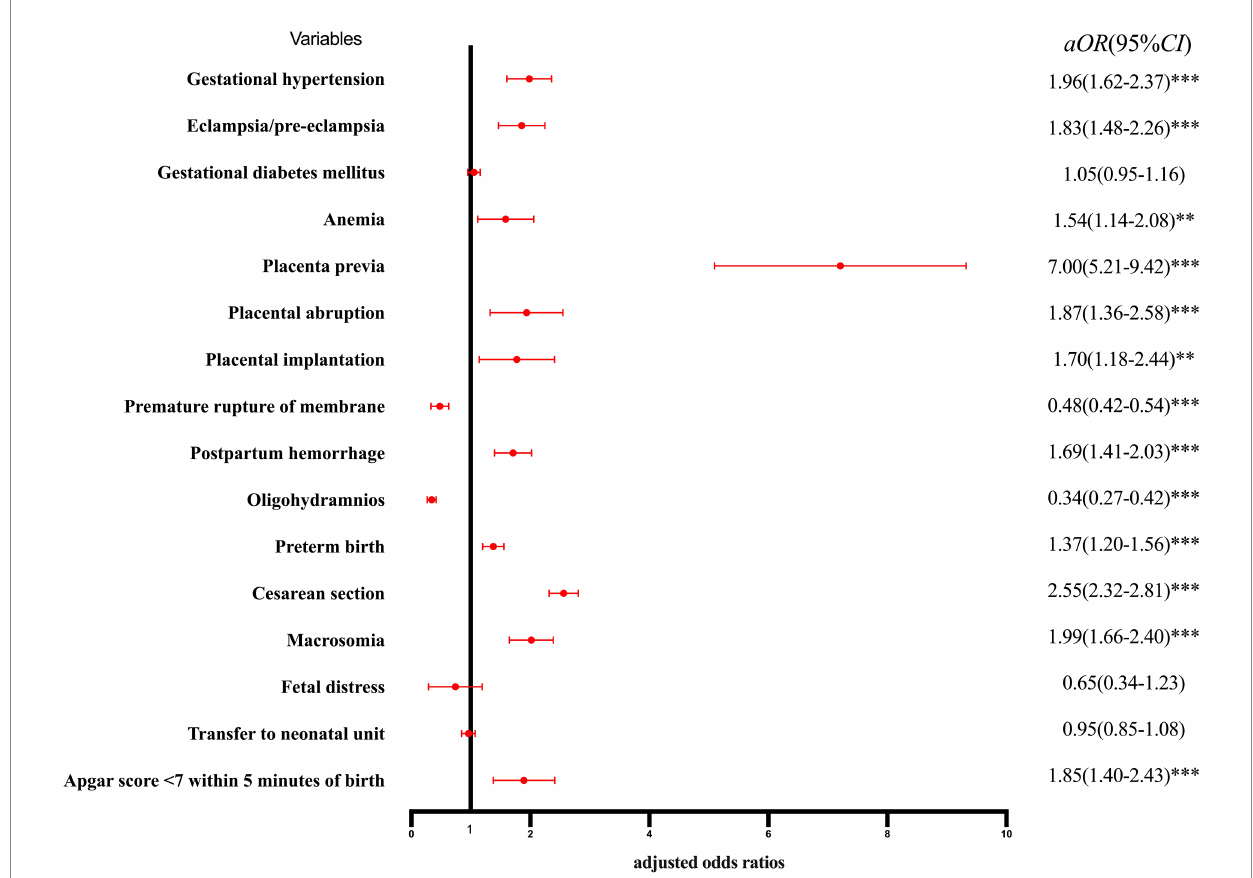
FIGURE 2 Forest plot for risk of adverse pregnancy outcomes and neonatal outcomes by single parity group. * p < 0.05, statistically difference, * p < 0.01, statistically significant difference, and *** p < 0.001, highly statistically significant